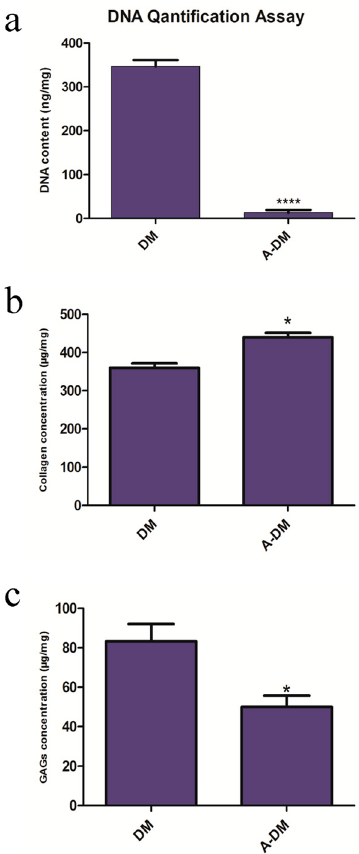
Figure 1. FADM characterization. DNA content dramatically decreased after decellularization of the matrix (**** p < 0.0001) ( a ). Higher collagen concentration ( b ) and lower GAGs content ( c ) were observed in FADM (* p < 0.05).